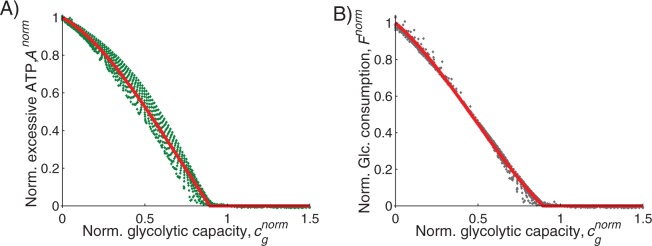
Normalized cost terms.(A) Normalized excessive ATP, Anorm, and (B) normalized glucose consumption, Fnorm, as function of normalized glycolytic capacity, cgnorm, for efficiency ration of fg/o = 2. Dots are overlay of all values between PL = 1, 1¼, 1½, …, 5. Red lines are quadratic polynomial fit, which is used for calculating production cost for any value of peak-demand and glycolytic capacity. Whether presented as panel (A) or (B), the optimal level of glycolytic capacity that minimizes costs occurs at the point where normalized excess ATP or normalized glucose consumption reaches 0.